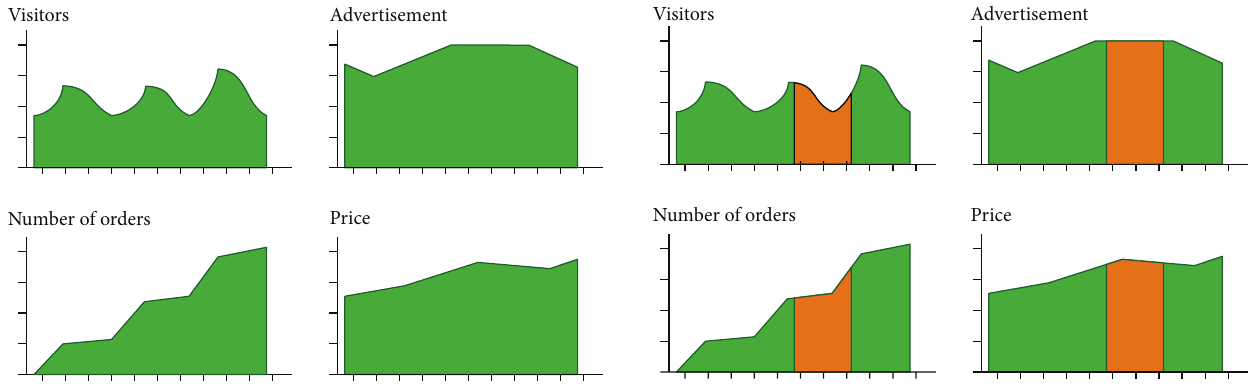
Figure 2: Data area selection onto related